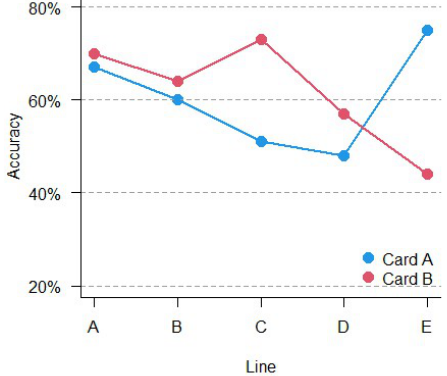
Figure 3. Accuracy comparison over card and lines.